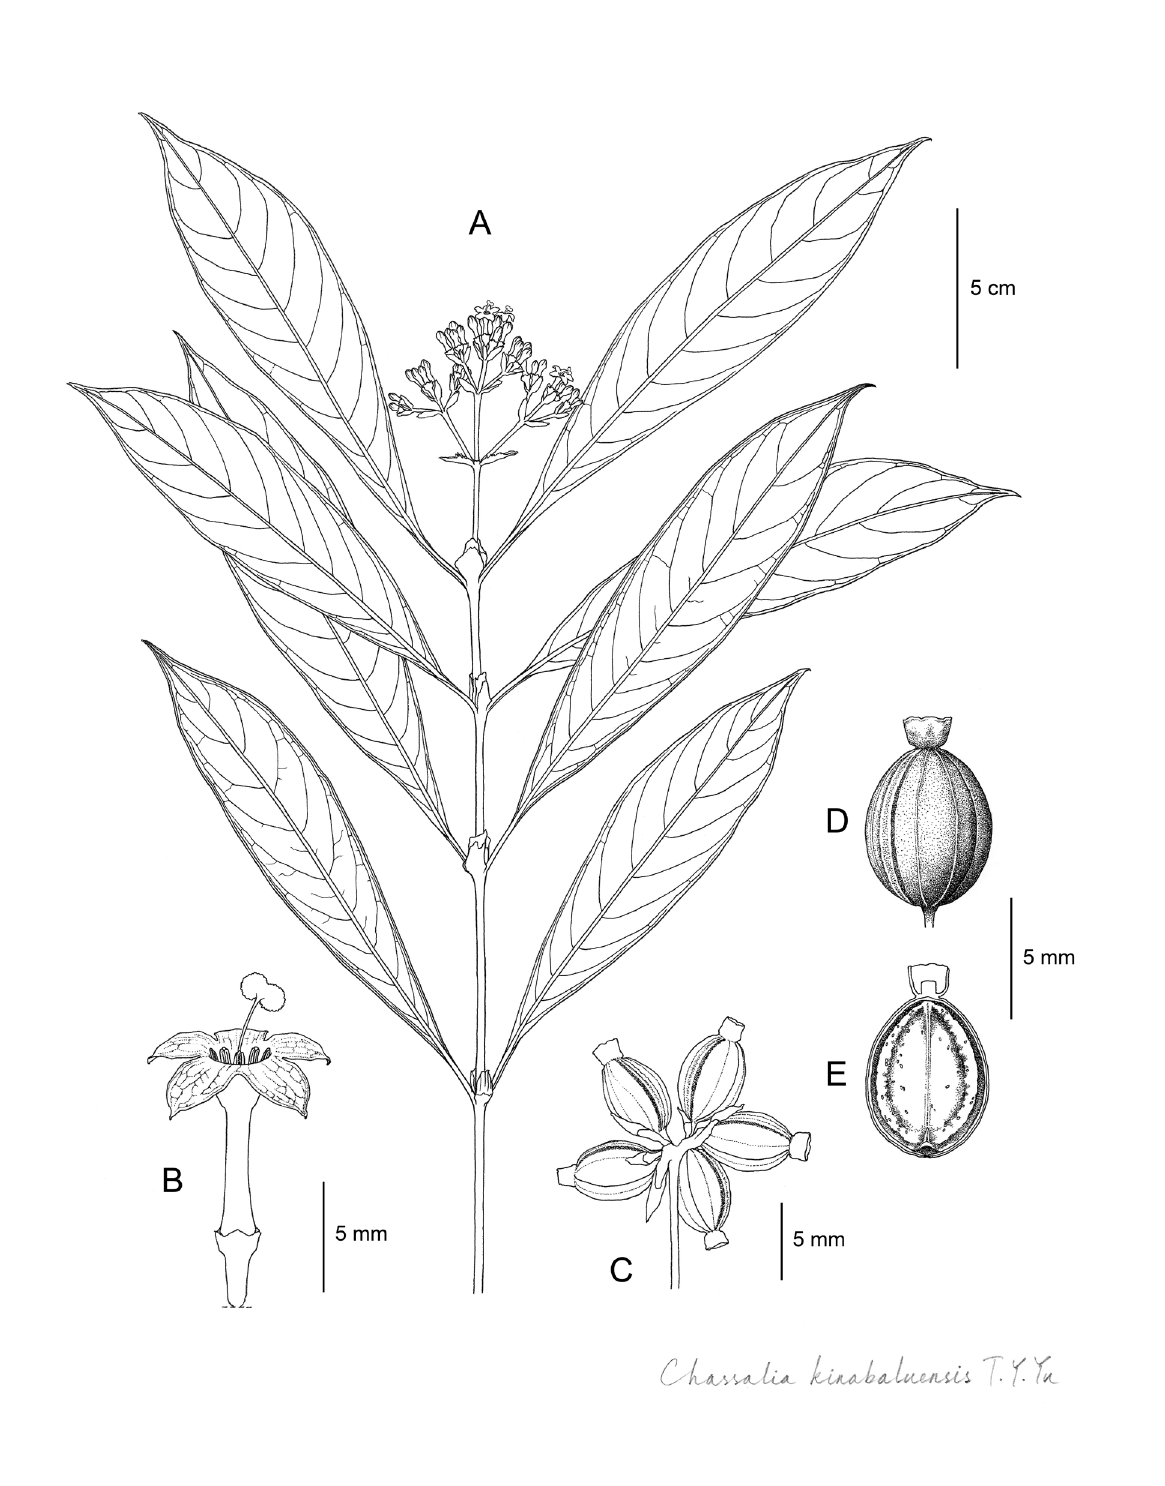
Fig. 14. Chassalia kinabaluensis T.Y.Yu sp. nov. A . Flowering shoot. B . Flower. C . Part of infructescence. D . Dry fruit. E . Pyrene ventral surface. From John H. Beaman 11299 . Drawn by T.Y.